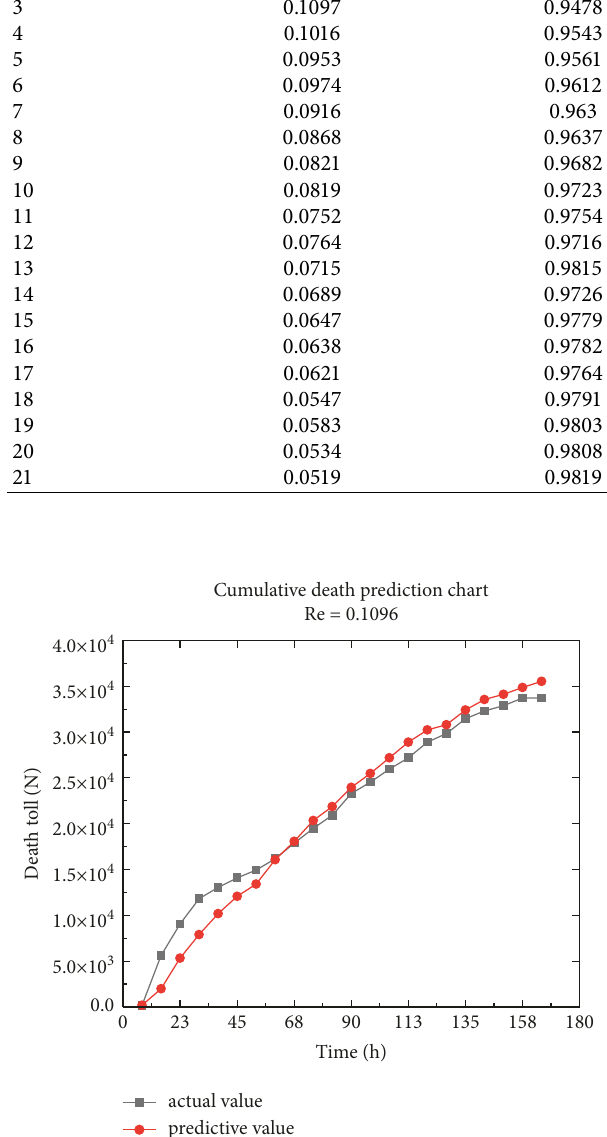
Figure 7: Prediction results of the last rolling period.